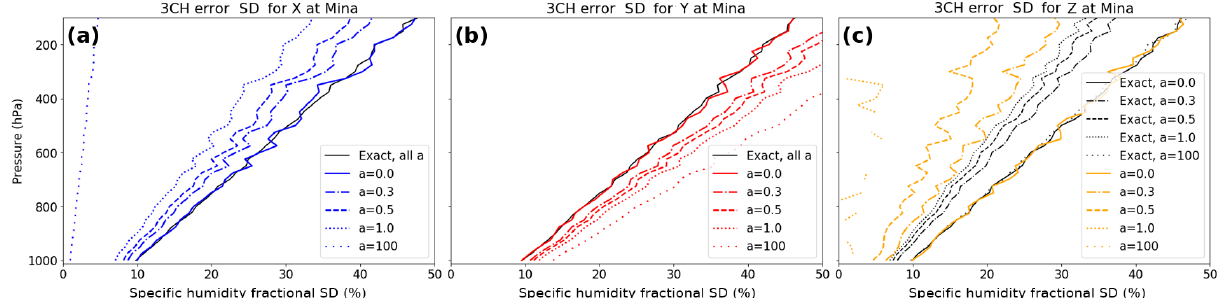
Figure 3. (a) Estimated standard deviation of X err for values of a = 0, 0.3, 0.5, 1.0 and 100 computed from Eqs. (3a)–(5a). Exact SD computed from data set X (solid black profile). (b) Same as (a) except for estimated SD of Y err . (c) Same as (a) except for estimated SD of Z err . Note that for different values of a , the exact SD of X err and Y err are always the same. The exact SD of Z err decreases as a increases for 0 < a < 1 . 0. For a > 1 . 0, the exact SD of Z err increases as a increases, becoming equal to the SD of X err for a = ∞ due to the way our error model is defined (see also Table 1). For a = 100 the correlation between X and Z errors is 0.99995 (Table 1; black dotted line for a = 100 almost identical to black solid line for a = 0).